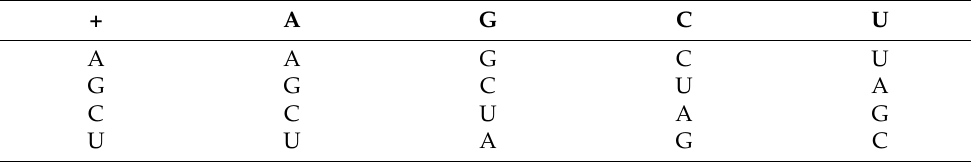
Table 3. RNA addition